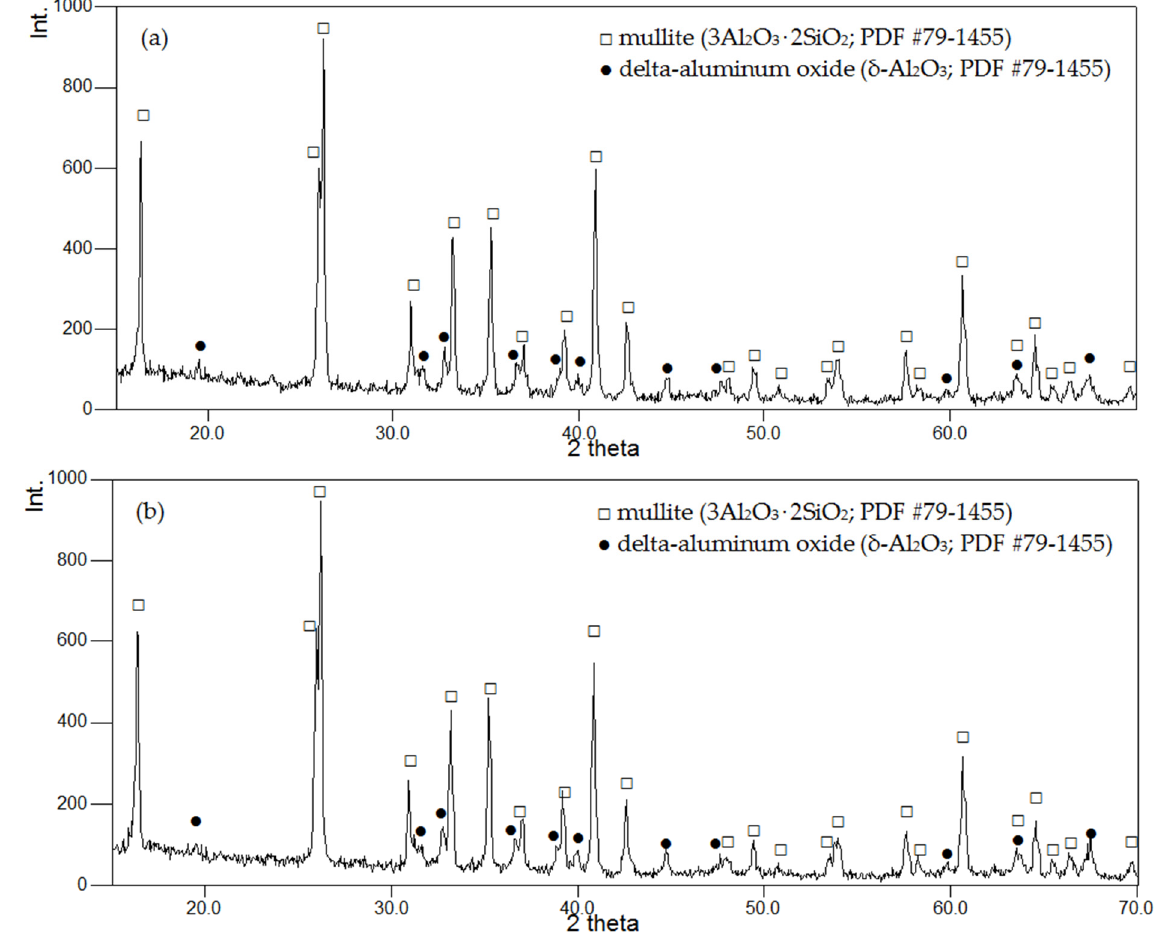
Figure 4. The diffraction pattern of the material II before exposure to concentrated solar radiation ( a ) as compared with that of the basic fiber [80% Al 2 O 3 + 20% SiO 2 ] ( b ).